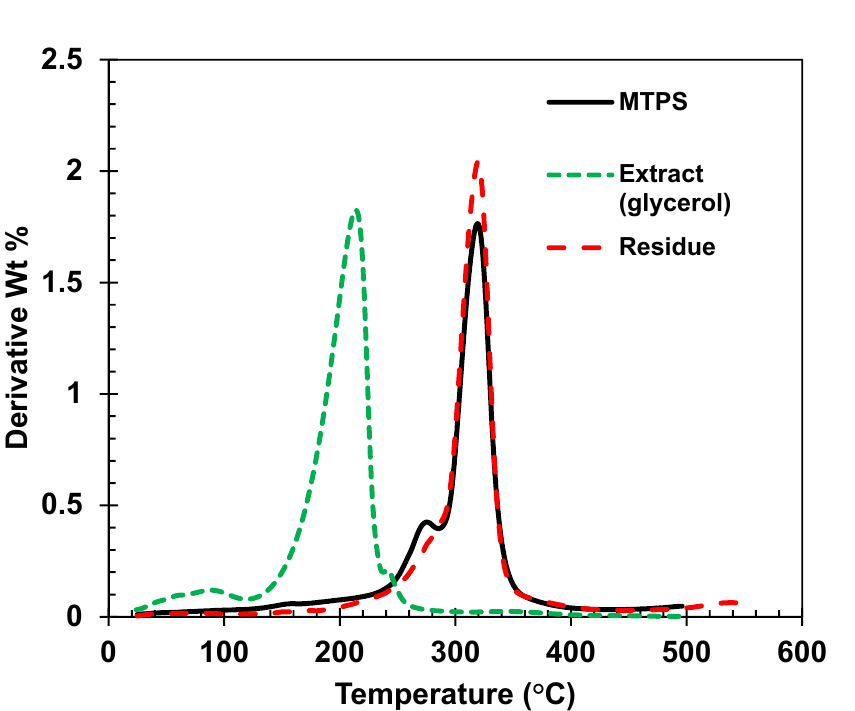
Figure 3. Derivative thermogravimetric (DTG) curves of MTPS, glycerol, and residue showing only MTPS after soxhlet extraction.